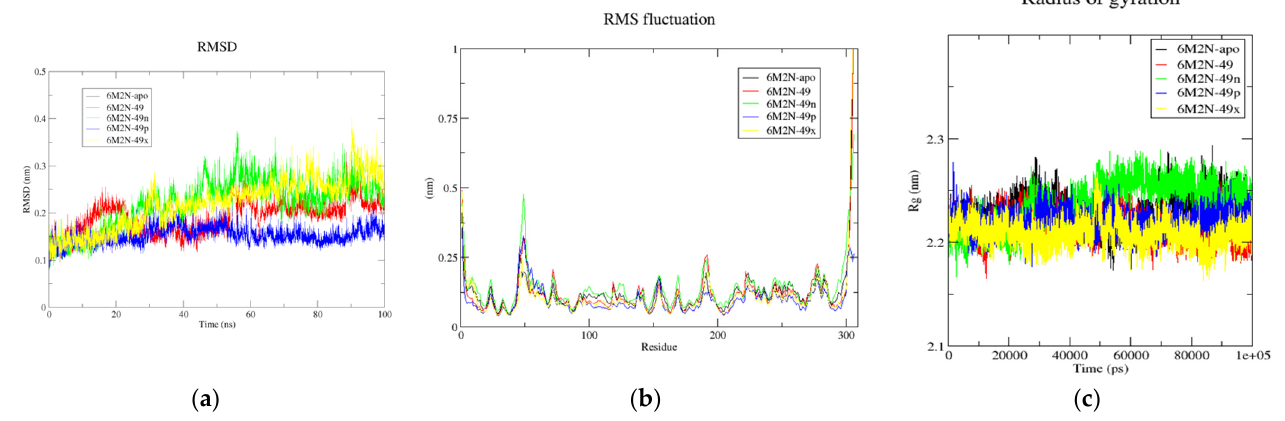
Figure 6. ( a ) Time-dependent RMSD of c- α backbone of the Mpro-apo, 6M2N-49, 6M2N-49n, 6M2N-49p, and 6M2N-49x. ( b ) The RMSF for c- α atoms of Mpro-apo, 6M2N-49, 6M2N-49n, 6M2N-49p, and 6M2N-49x. ( c ) Plot of Rg vs. time for Mpro-apo, 6M2N-49, 6M2N-49n, 6M2N-49p, and 6M2N-49x. Table 5. The calculated average parameters for all the systems throughout 100 ns MD simulation run.